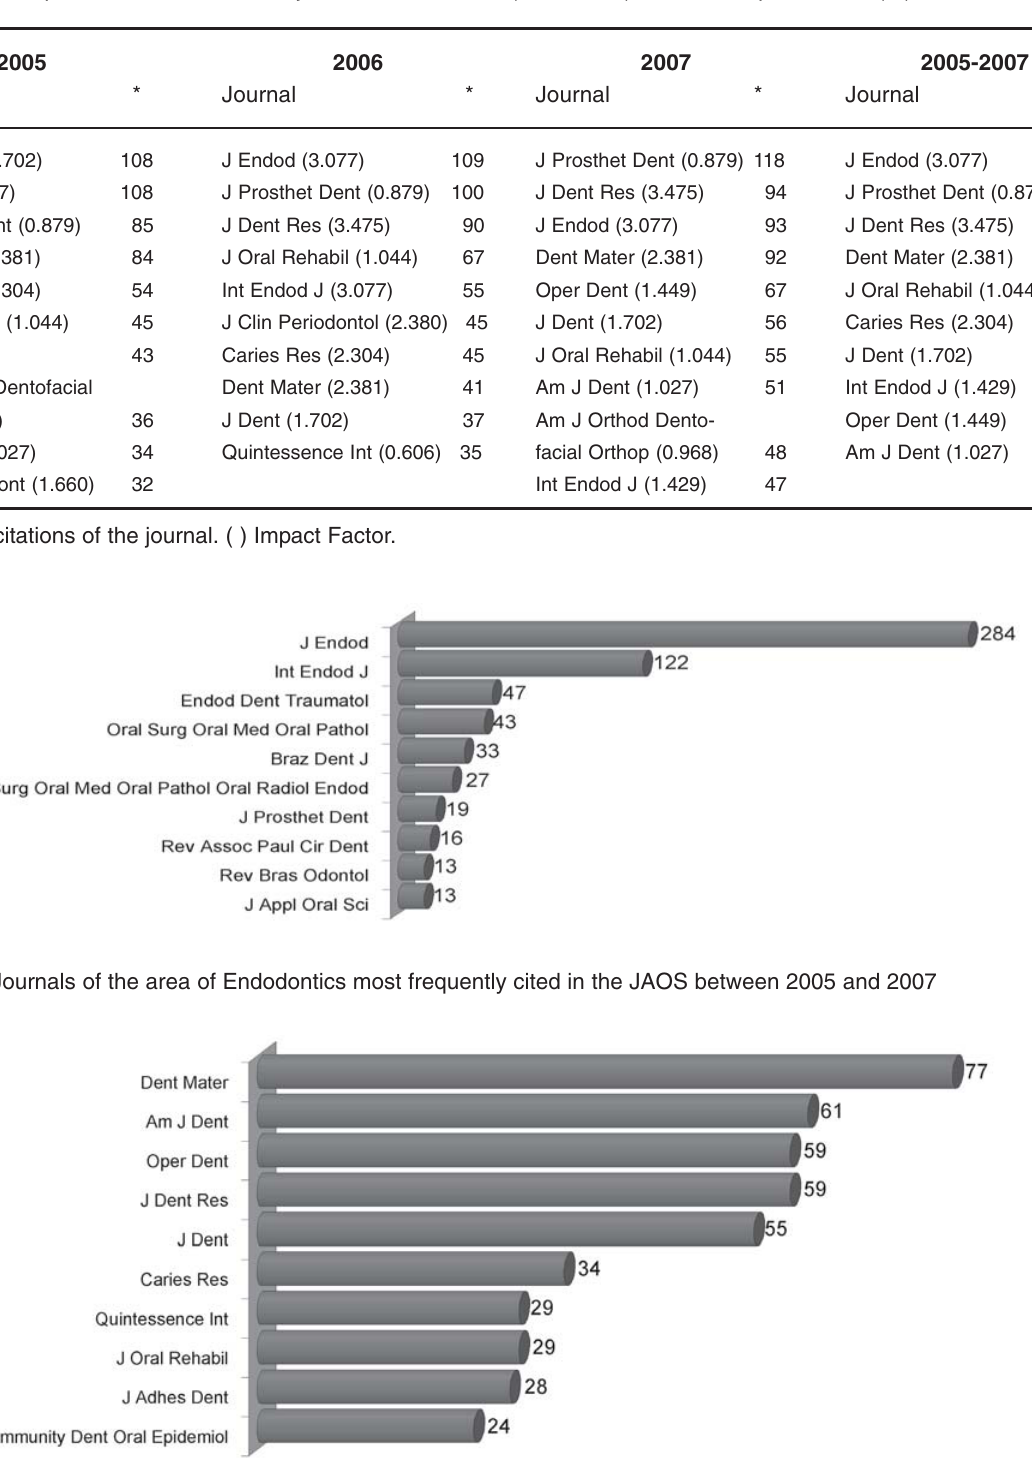
TABLE 5- The top 10 most cited scientific journals in the JAOS (2005-2007) and their Impact Factor (IF)